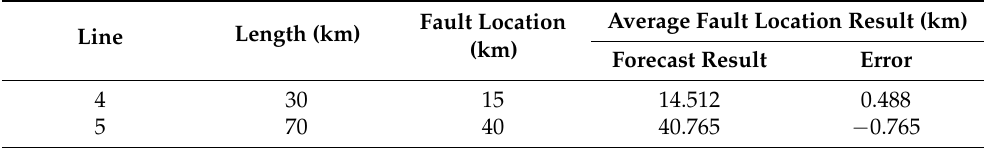
Table 3. Fault location performance of different models.